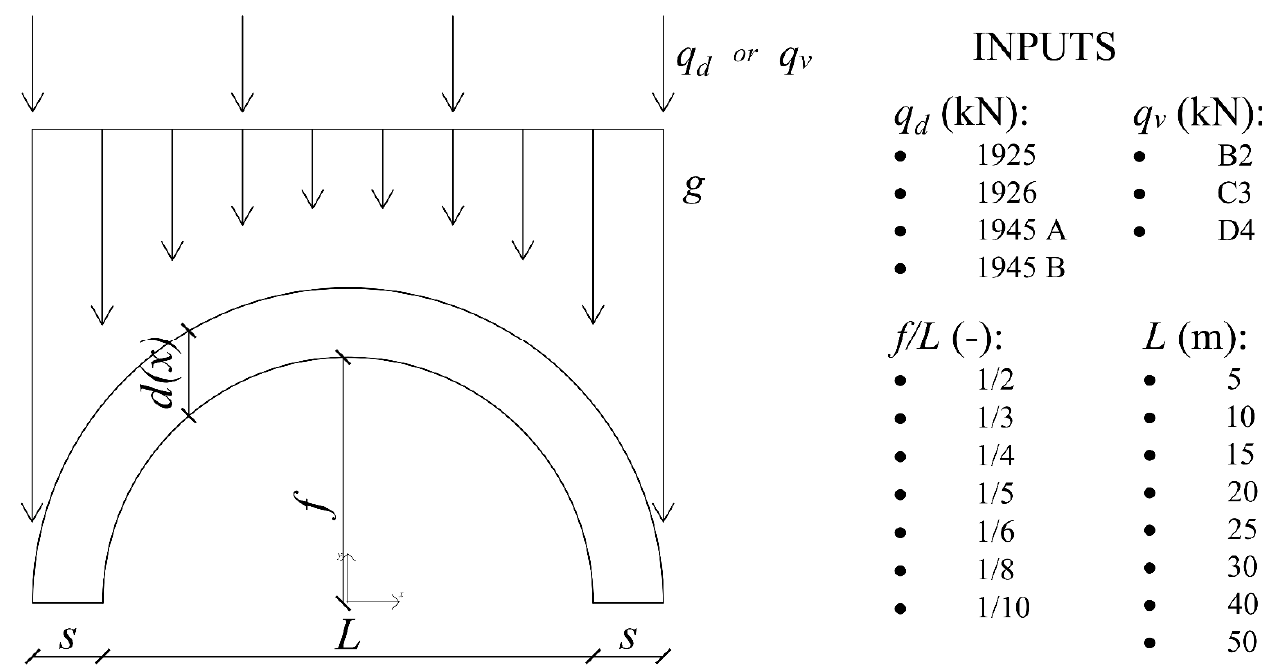
( d ) Figure 6. Lines of thrust obtained with the numerical algorithm for each case study, in comparison with the plastic hinges position obtained with the software Ring: ( a ) case study 1, ( b ) case study 2, ( c ) case study 3, ( d ) case study 4. The position of the plastic hinges coincides with good approximation for all the 4 validation case studies. In addition, even though Ring employs a more refined load redis- tribution rule (Boussinesq [57]), the results obtained with Ring and with the proposed numerical method are in good agreement, confirming that the accuracy of the imple- mented redistribution rule is sufficient at this stage.